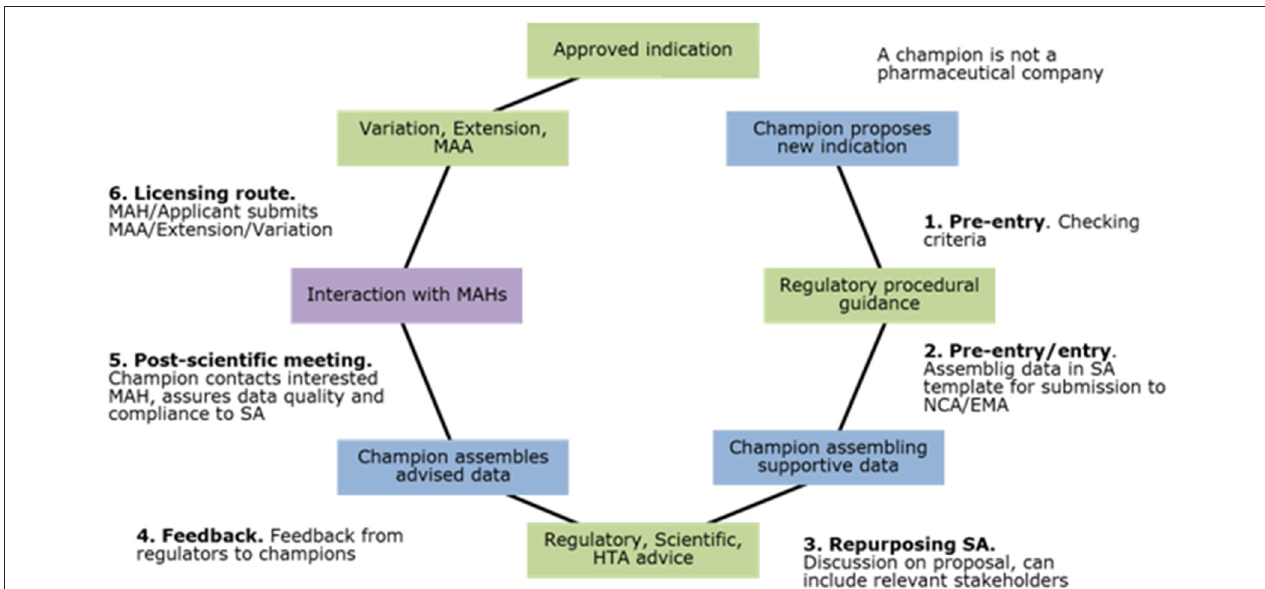
FIGURE 1 | Regulatory framework for the repurposing of medicinal products out of data and patent protection by